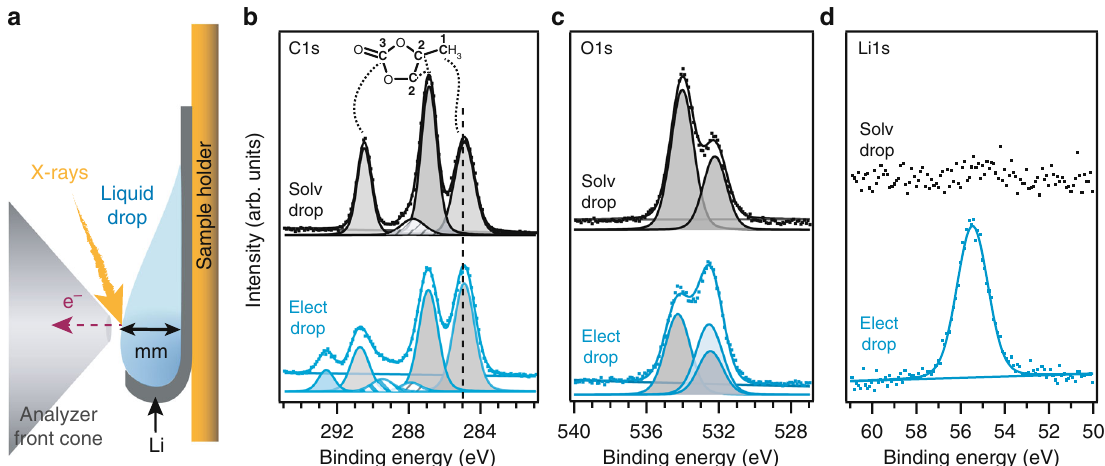
Fig. 1 APPES measurements of PC solvent and 1 M LiTFSI in PC electrolyte. Schematic side view representation of the respective liquid droplets on the Li substrate ( a ). C 1s ( b ), O 1s ( c ), and Li 1s ( d ) PES spectra of Solvent drop (Solv-Drop, top), and Electrolyte drop (Elect-Drop, 1 M LiTFSI in PC, as prepared, bottom)